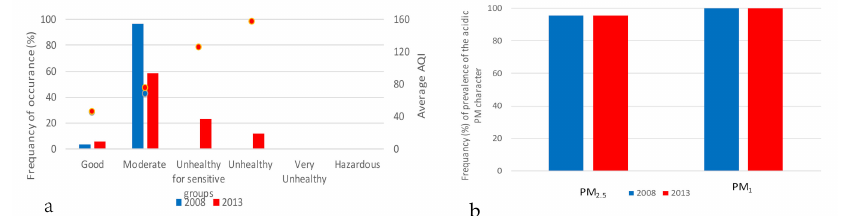
Figure 4. Frequency of occurrence (%) of ( a ) the health categories and the average AQI in connection with PM 2.5 and ( b ) the prevalence of the acidic PM character during March of 2008 and